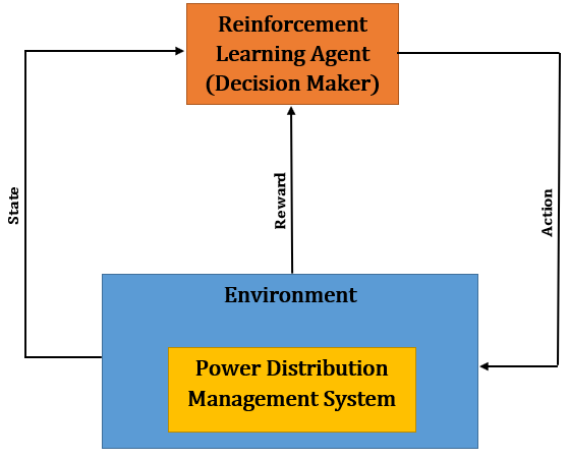
Figure 14. Reinforcement Learning Agent .